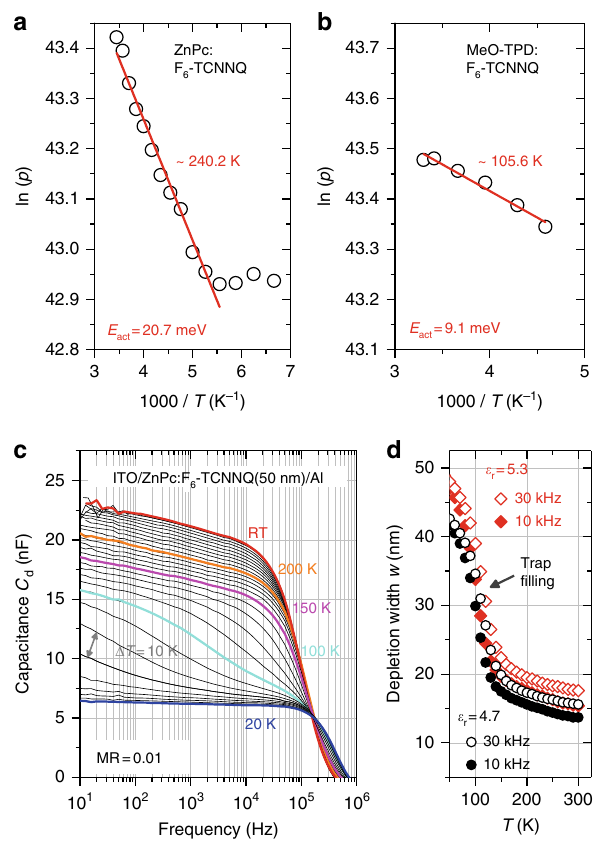
Fig. 3 Impedance spectroscopy on p-doped fi lms. Arrhenius-type doping activation determined by Mott-Schottky analysis on ITO/host:F 6 -TCNNQ (50 nm)/Al diodes with a ZnPc or b MeO-TPD as host, respectively. c C ( f ) spectra of the ZnPc:F 6 -TCNNQ device at zero bias and varying sample temperature from RT to 20 K in steps of Δ T = 10 K. Doping freeze-out causes steadily increasing depletion and, for T ≤ 100 K, vanishing trap response. d Depletion width w calculated from ( b ) at 10 and 30 kHz, and ε r = {4.7; 5.3} Table 1 Compilation of Arrhenius-type activation